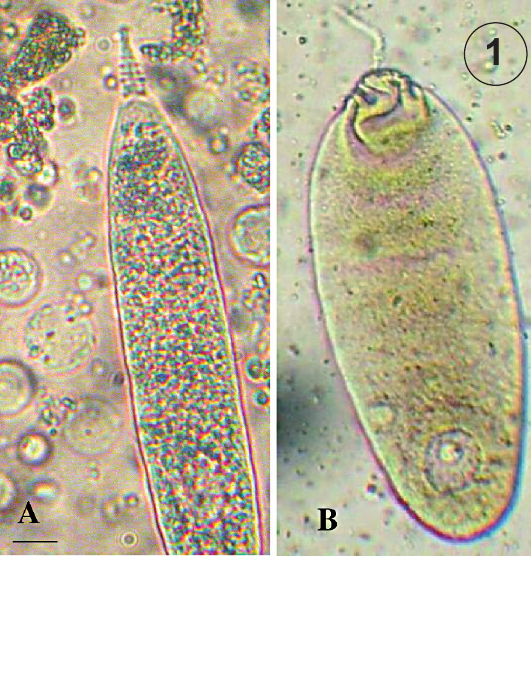
Fig. 1. – Bhatiella marphysae Setna, 1931. A. Trophozoïte; B. Détail de la région antérieure. Trait d’échelle commun à A et B : 33 µm. Fig. 2. – Viviera sp. Trophozoïtes. Trait d’échelle commun à A et B : 33 µm. Fig. 3. – Ferraria cornucephala iwamusi Hoshide, 1958. A, B. Trophozoïtes. Le cloisonnement partiel du deutomérite est visible en B. S1 : septum proto-deutoméritique; S2 : septa secondaires. Trait d’échelle commun à A et B : 40